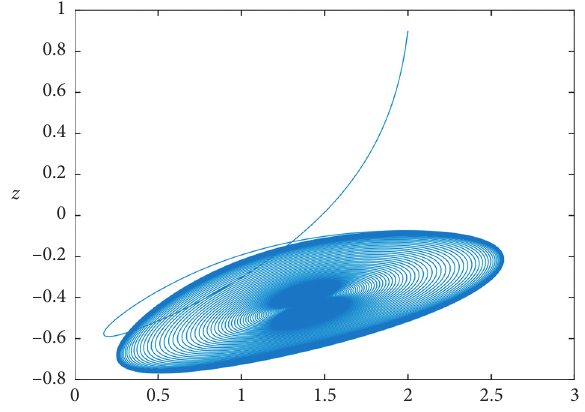
Figure 17: Dynamic behavior of fractional financial chaotic model with α � 0 . 95.